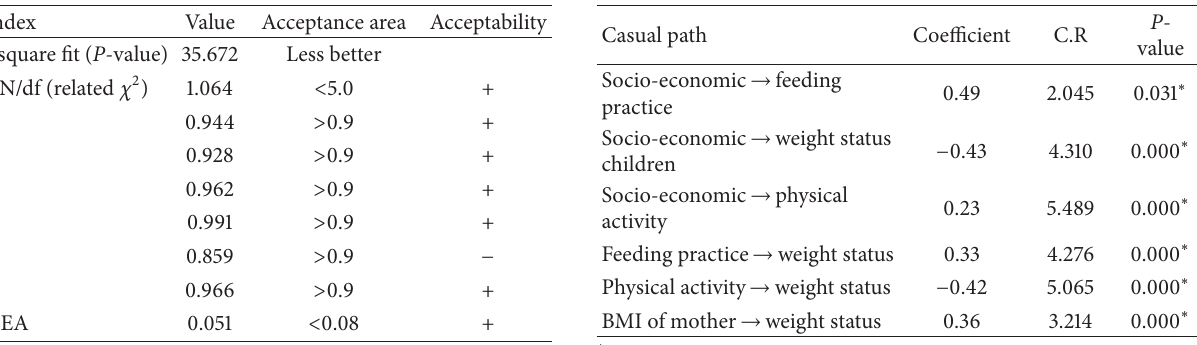
Table 8: Regression weight for individual path in full structural